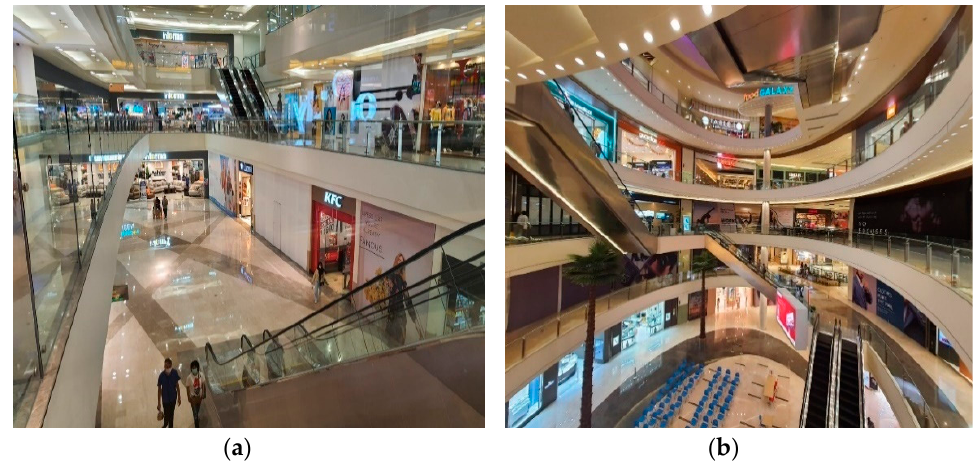
Figure 7. Comparison of shopping center TP 1 ( a ) and TP 5 ( b ).